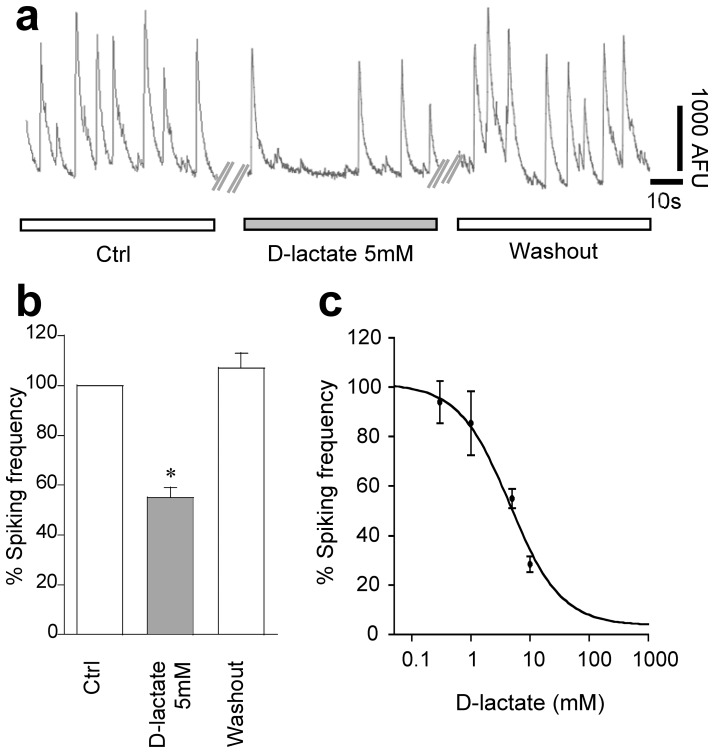
D-lactate effects on neuronal activity.(a) Sample trace of calcium transients in control or 5 mM D-lactate containing solution. (b) D-lactate substantially decreased calcium transient frequency. (c) The concentration-response analysis yielded an apparent IC50 of 4.6±1.2 mM (n = 127 cells; 21exp).